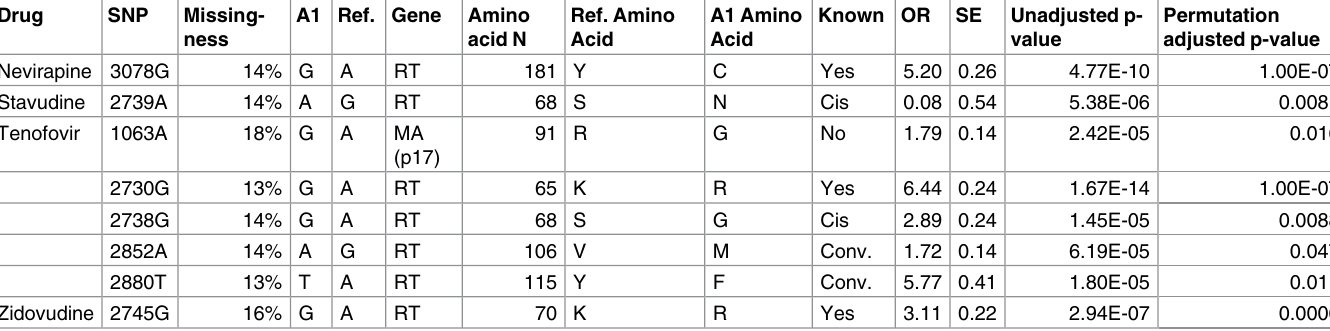
Table 2. Results for genome-wide significant SNPs and their corresponding amino acid positions.